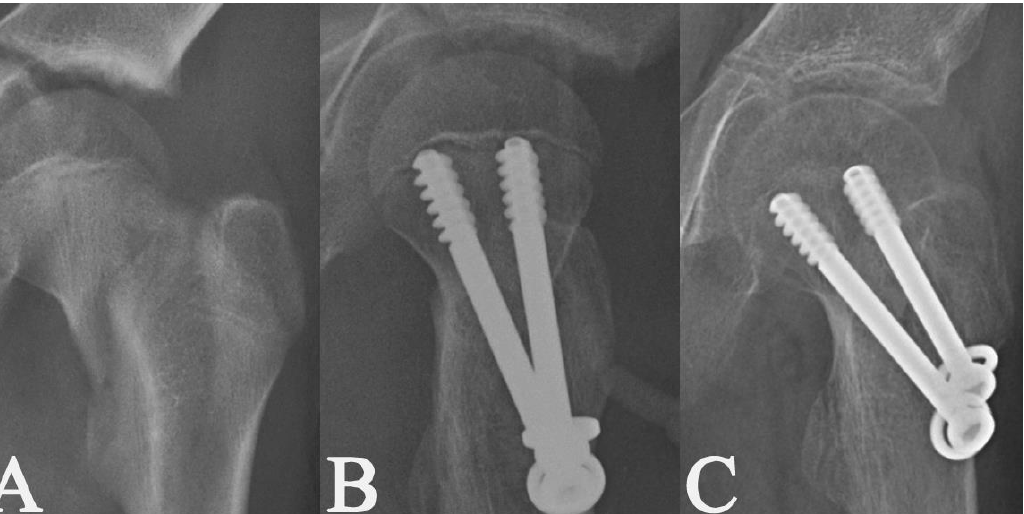
Figure 7. Radiographs of a 12-year-old boy with a displaced Delbet – Colonna type III fracture [15] ( A ); radiographs after open reduction and internal fixation with 2 cannulated ˅ -shape screws; the fracture was completely compressed by the screws with the threads above the fracture line ( B ); the radiological healing at 3.5 months post-surgery ( C ).